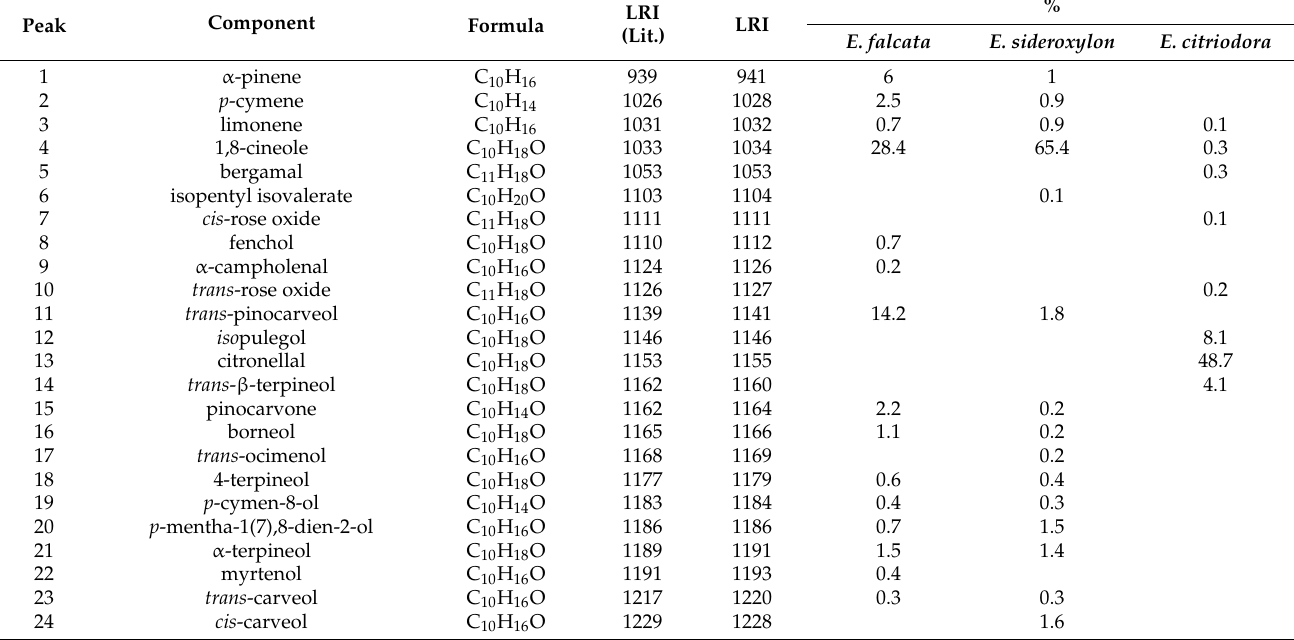
Table 2. Chemical compositions of essential oils of Eucalyptus